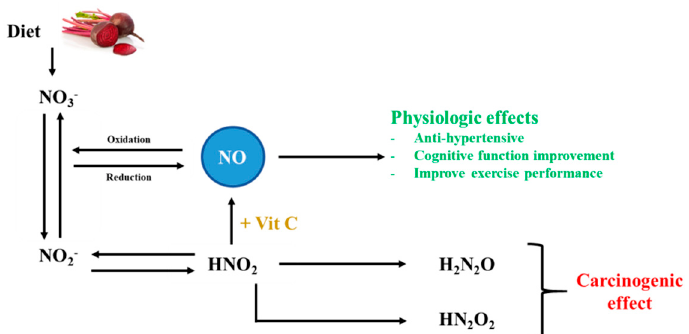
Figure 2. Conversion of nitrate and nitrite into nitrosamines. NO 3 − : nitrate, NO 2 − : nitrite, NO: nitric oxide, HNO 2 : nitrous acid, H 2 N 2 O: nitrosamines, HN 2 O 2 : nitrosamides, Vit C: vitamin C. Adapted from Berends et al., 2019 [40].